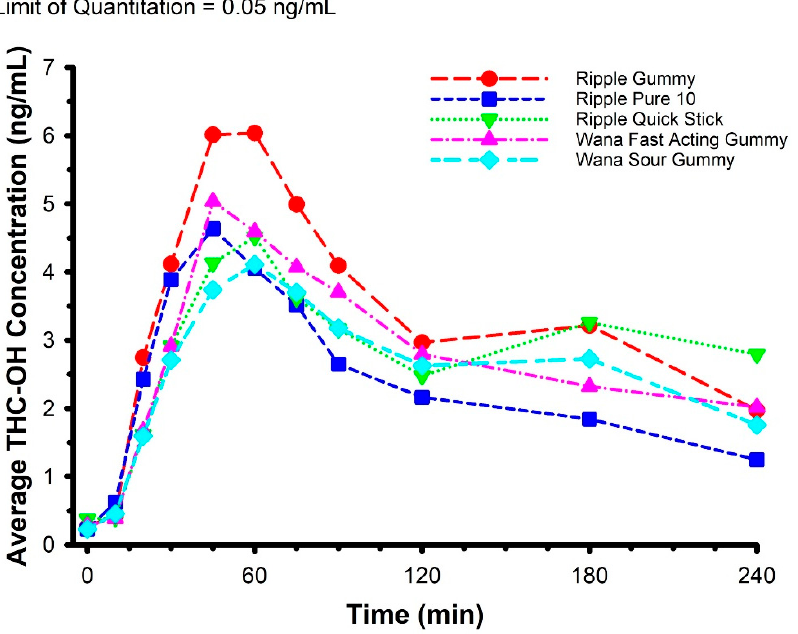
Figure 3. Mean circulating concentrations of THC-OH following ingestion of commercially available edible marijuana (10 mg of THC). There were no product × time interactions ( p = 0.415). Error bars have been omitted for clarity.